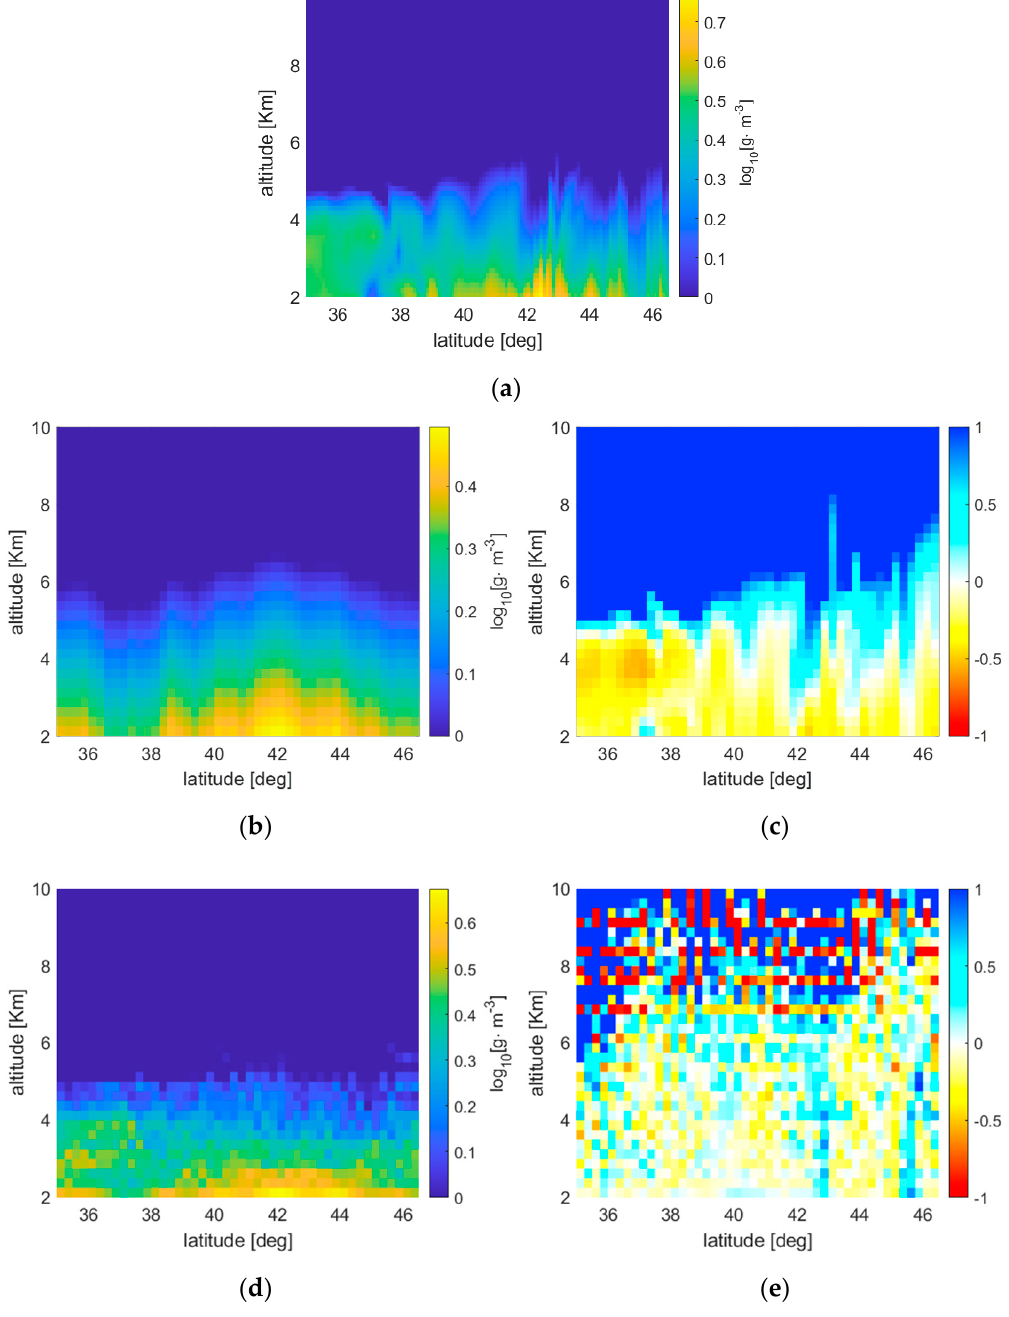
Figure 6. ( a ) True WV field (analysis of 24 July 2020 11:30 a.m.) as a function of angle and altitude; ( b ) retrieved WV field with ERTA and ( c ) the corresponding normalized error field; ( d ) retrieved WV field with LSATR and ( e ) the corresponding normalized error field defined as in Equation (17). Satellite configuration: 1Tx ‐ 10Rx.